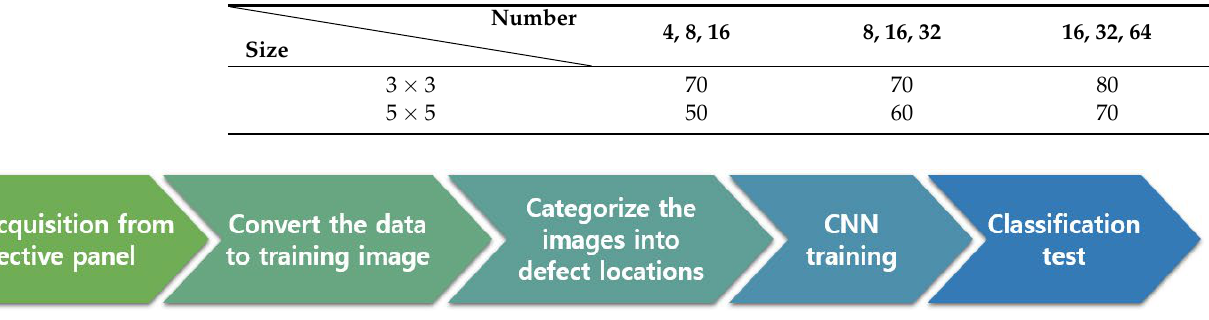
Figure 20. CNN training process for classification.